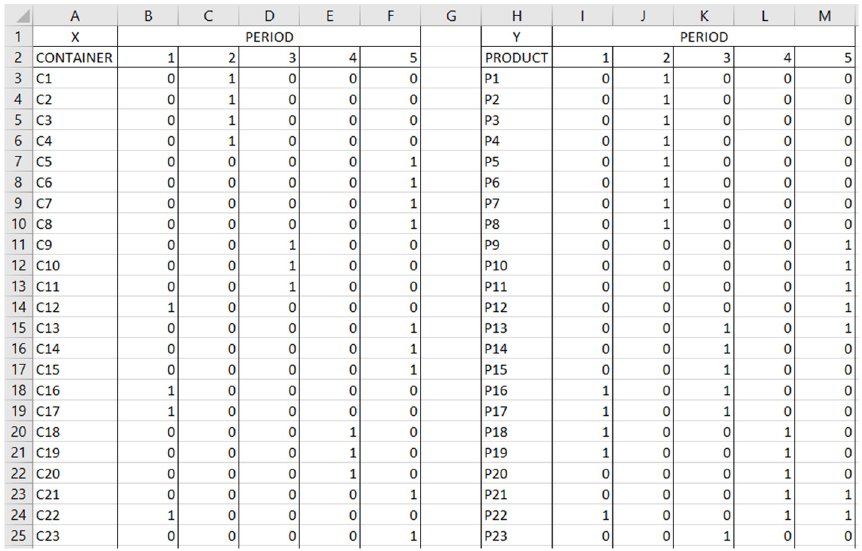
Figure 6. Quantity of products inside containers, Case 2, in the form of an Excel spreadsheet.